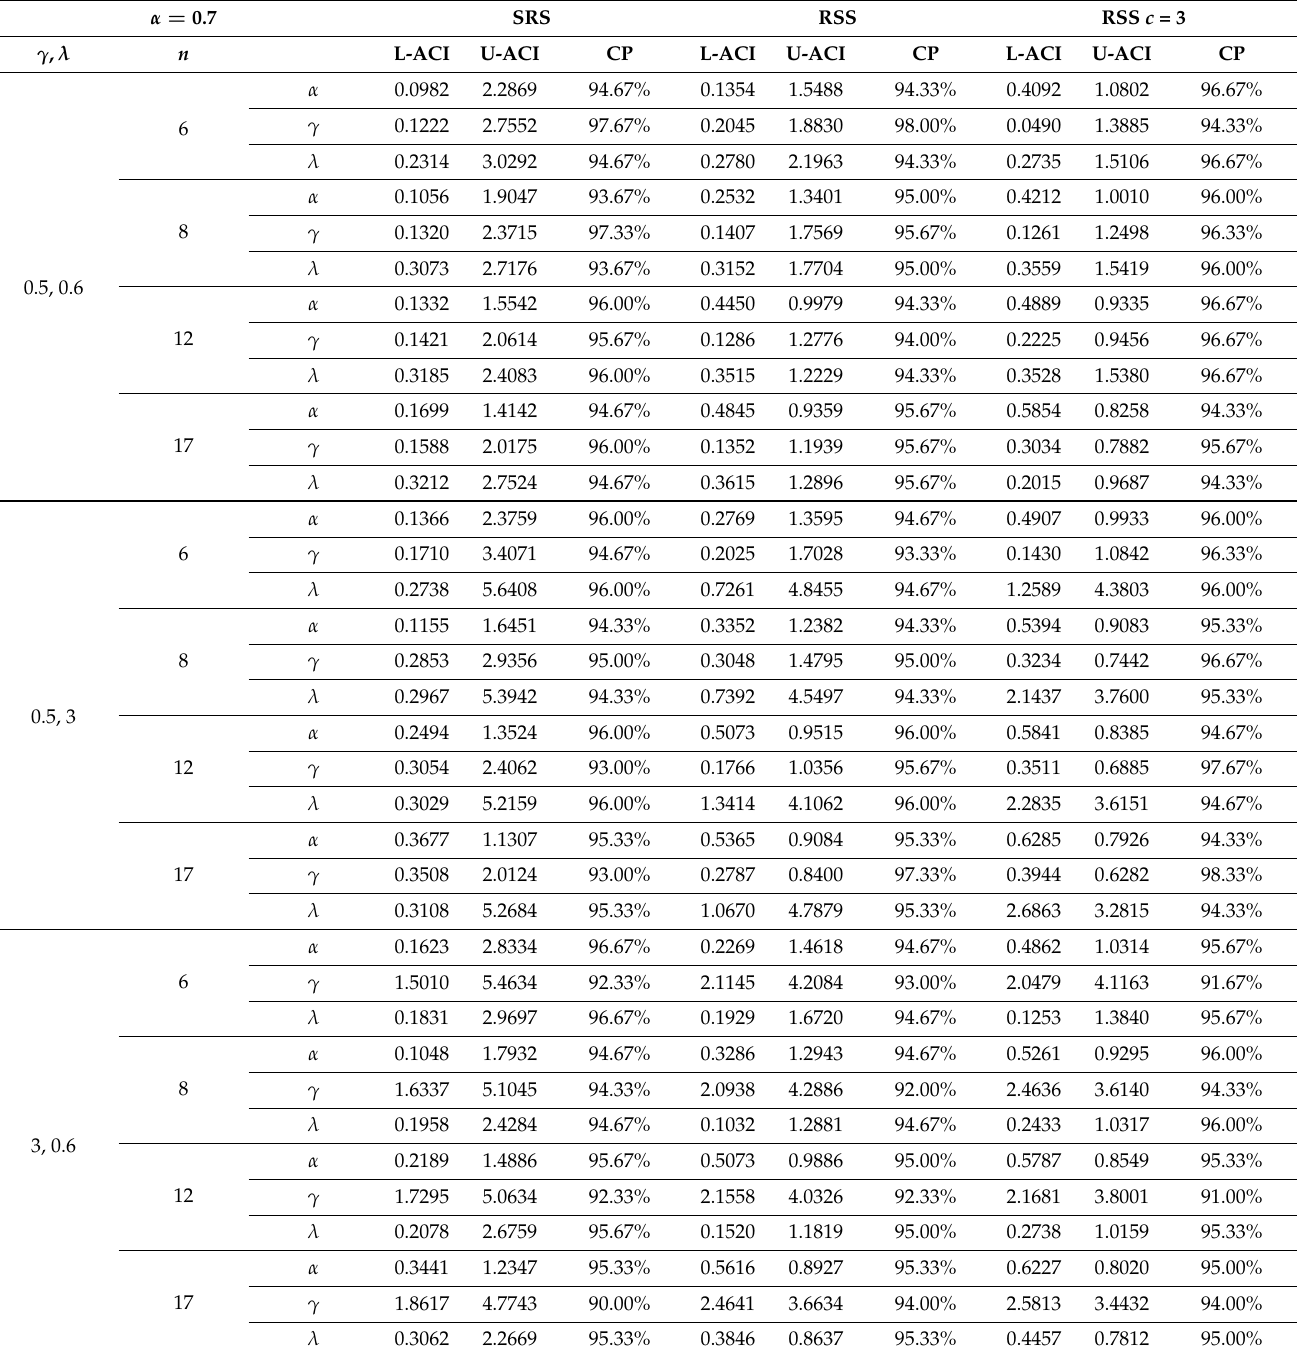
Table 7. Confidence intervals with CP for the parameters of the HL-INH distribution: α =